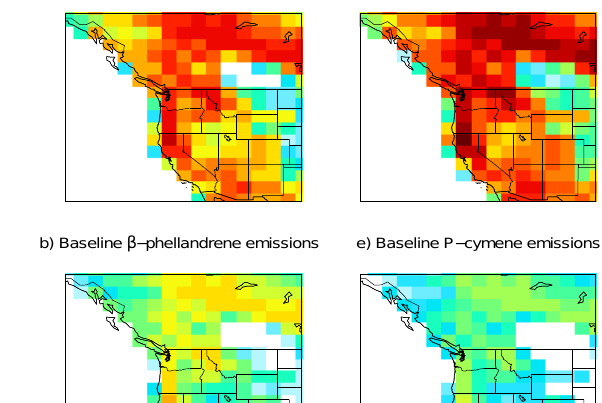
Table 3. Dark ozonolysis SOA yields from Lee et al. (2006a, or other studies as noted) and reaction rates from Atkinson et al. (1997). Primary oxidant O 3 .